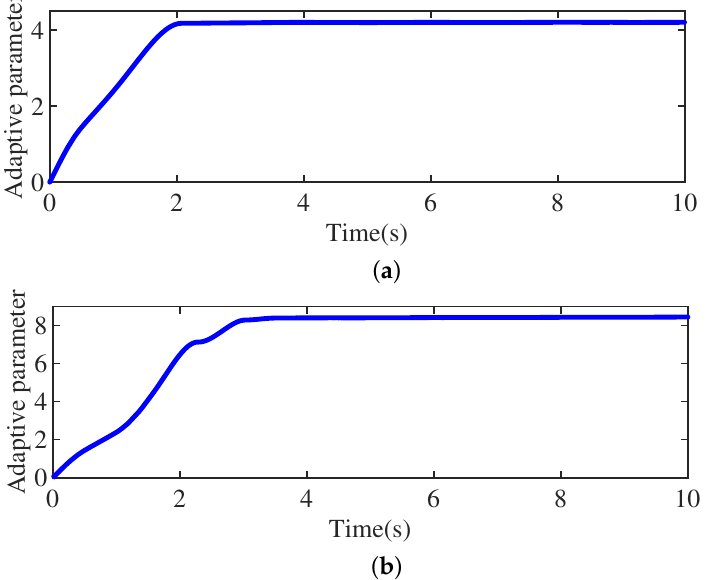
Figure 7. Variation of the adaptive parameter of INFTSM: ( a ) in normal situation and ( b ) in fault situation.